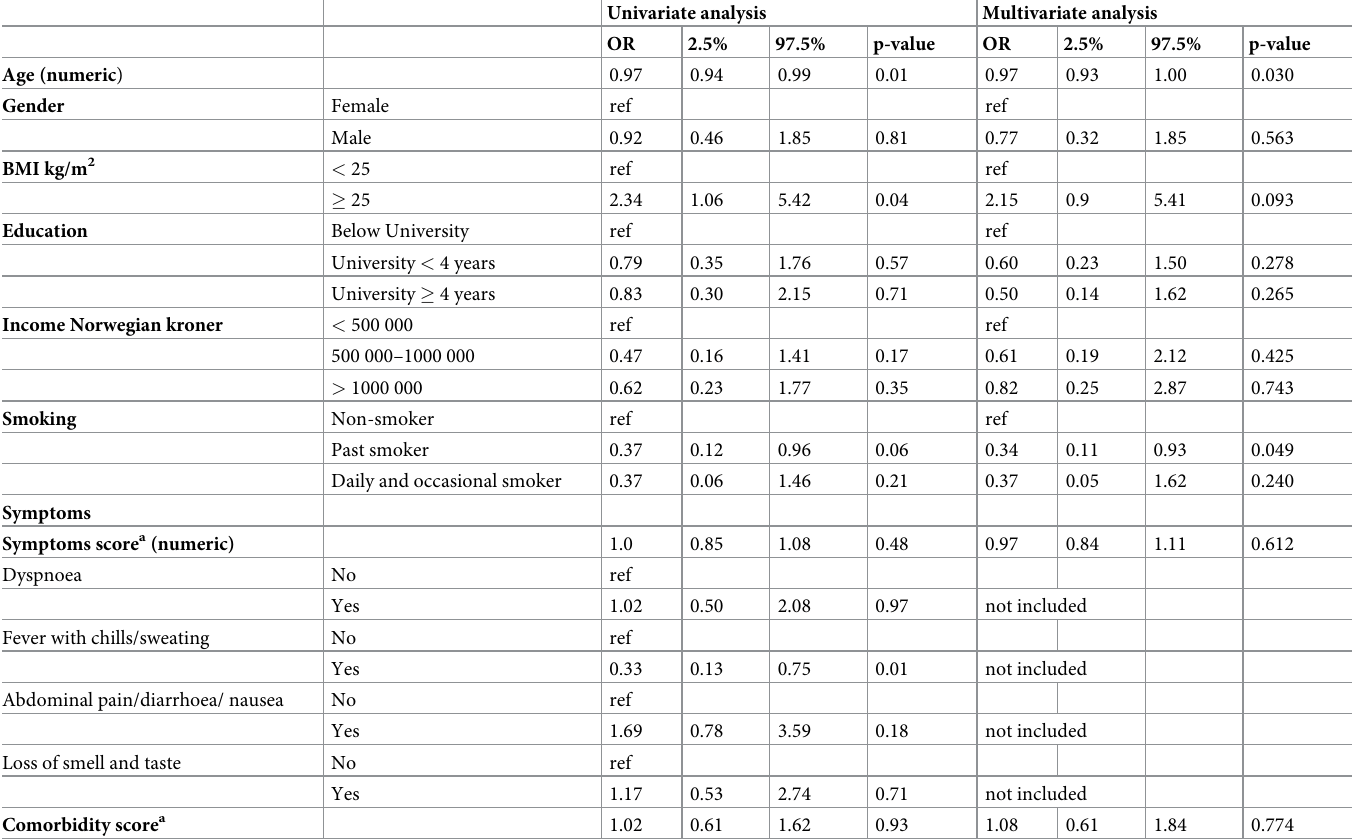
a Total symptom and comorbidity scores were calculated by adding the number of symptoms or comorbidities for each participant, and used instead of single variables in the multivariate